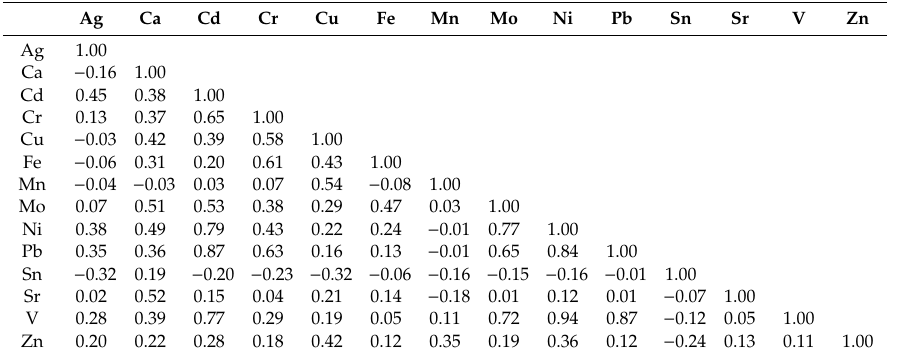
Table 9. Pearson’s coe ffi cients for correlations between biological parameters of the mother, newborn, and placenta, and the concentrations of Ca, Cd, Cr, Cu, Fe, Mn, Mo, Ni, Pb V, and Zn in the placenta ( p < 0.05). Parameter Ag Ca